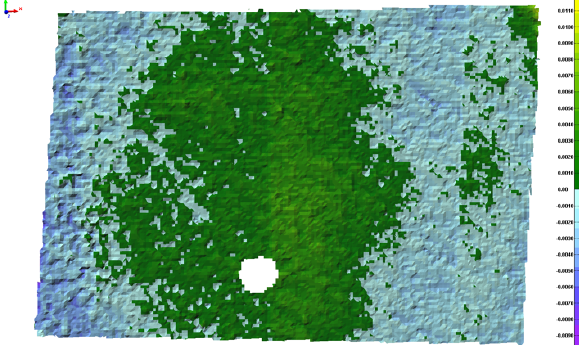
Figure 3. Color-coded deviation from the best-fitting plane originated by a range map acquired with the ASUS Xtion device while capturing the reference plane located at 650mm by the sensor. The color scale ranges from -12mm (pink) to +12mm (yellow).